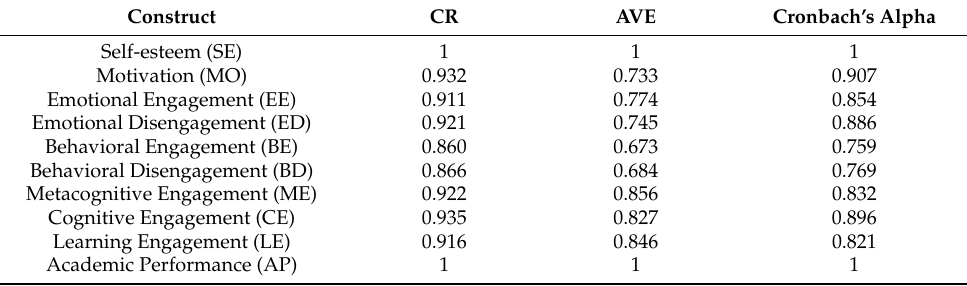
Table 1. CR, AVE, and Cronbach’s alpha of the constructs of the causal model.